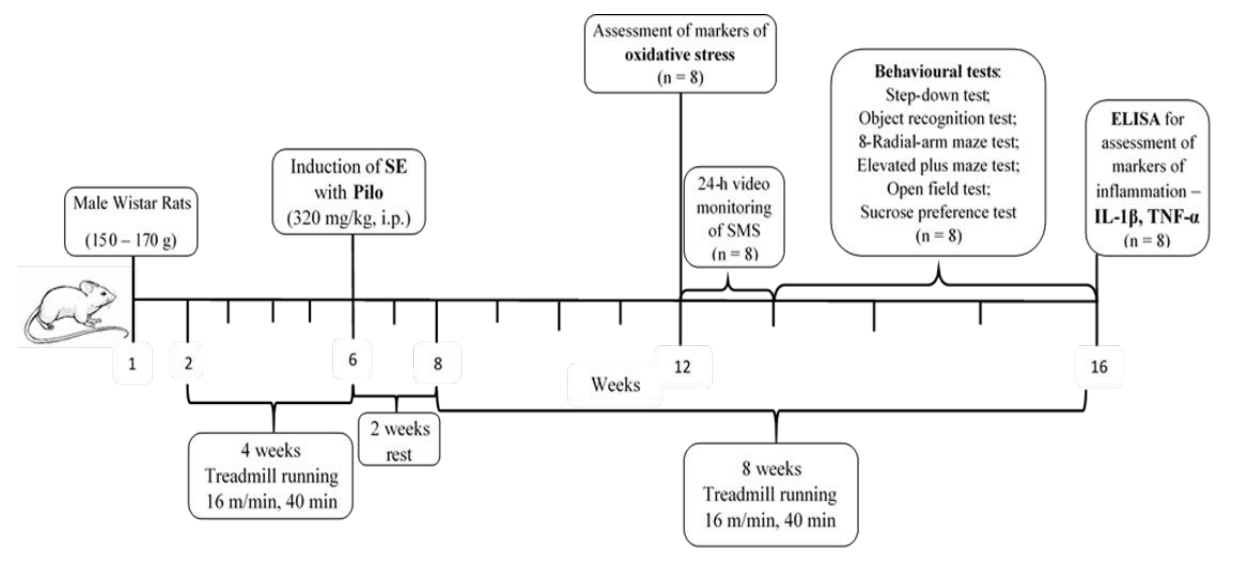
Figure 10. Timeline of the experimental protocol.